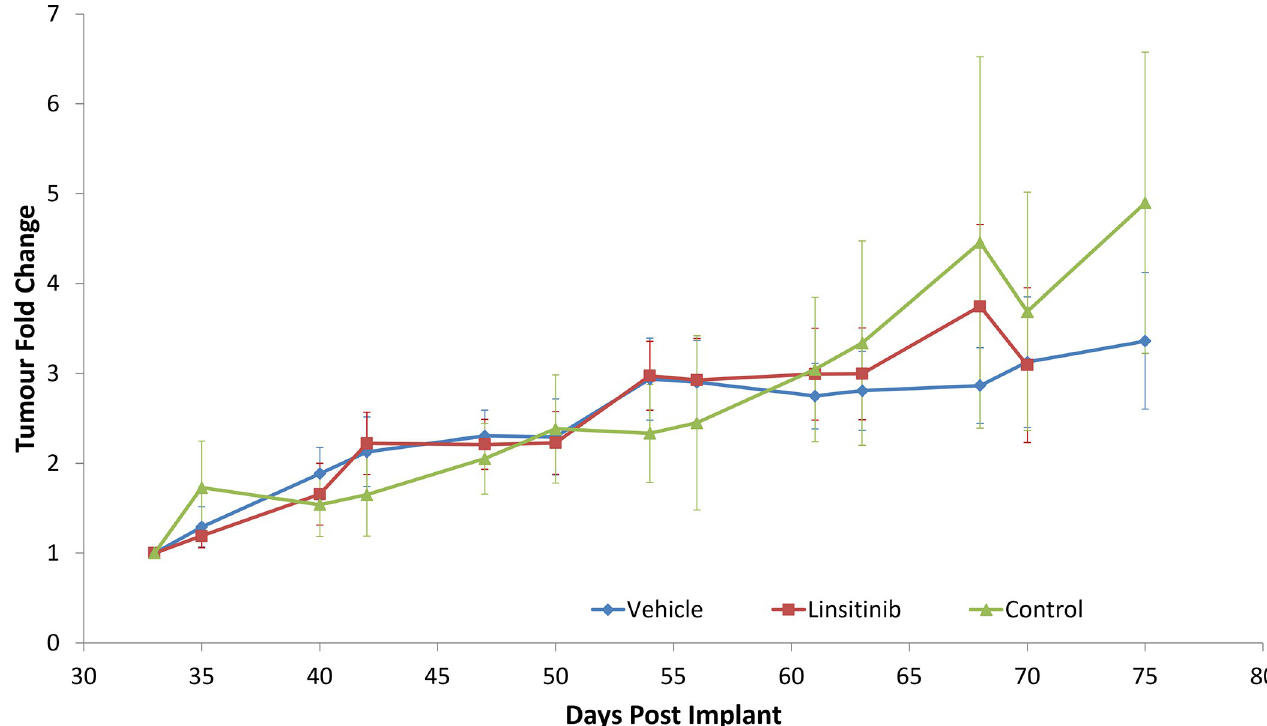
Fig 4. Effect of linsitinib and vehicle control on tumour volume, compared to untreated control. HCC1143 cells were implanted by subcutaneous injection into SCID mice. Animals were randomised to three arms; control, vehicle or linsitinib. Treatments, linsitinib (25 mg/kg) or vehicle were commenced 4 days post-implantation. Tumour volumes were assessed by callipers measurement. Tumour volumes were normalised to volume at day 33, as the starting point for tumour measurement, and represented as the mean and SEM. Tumour volumes arms were stopped when 5 animals remained on study.